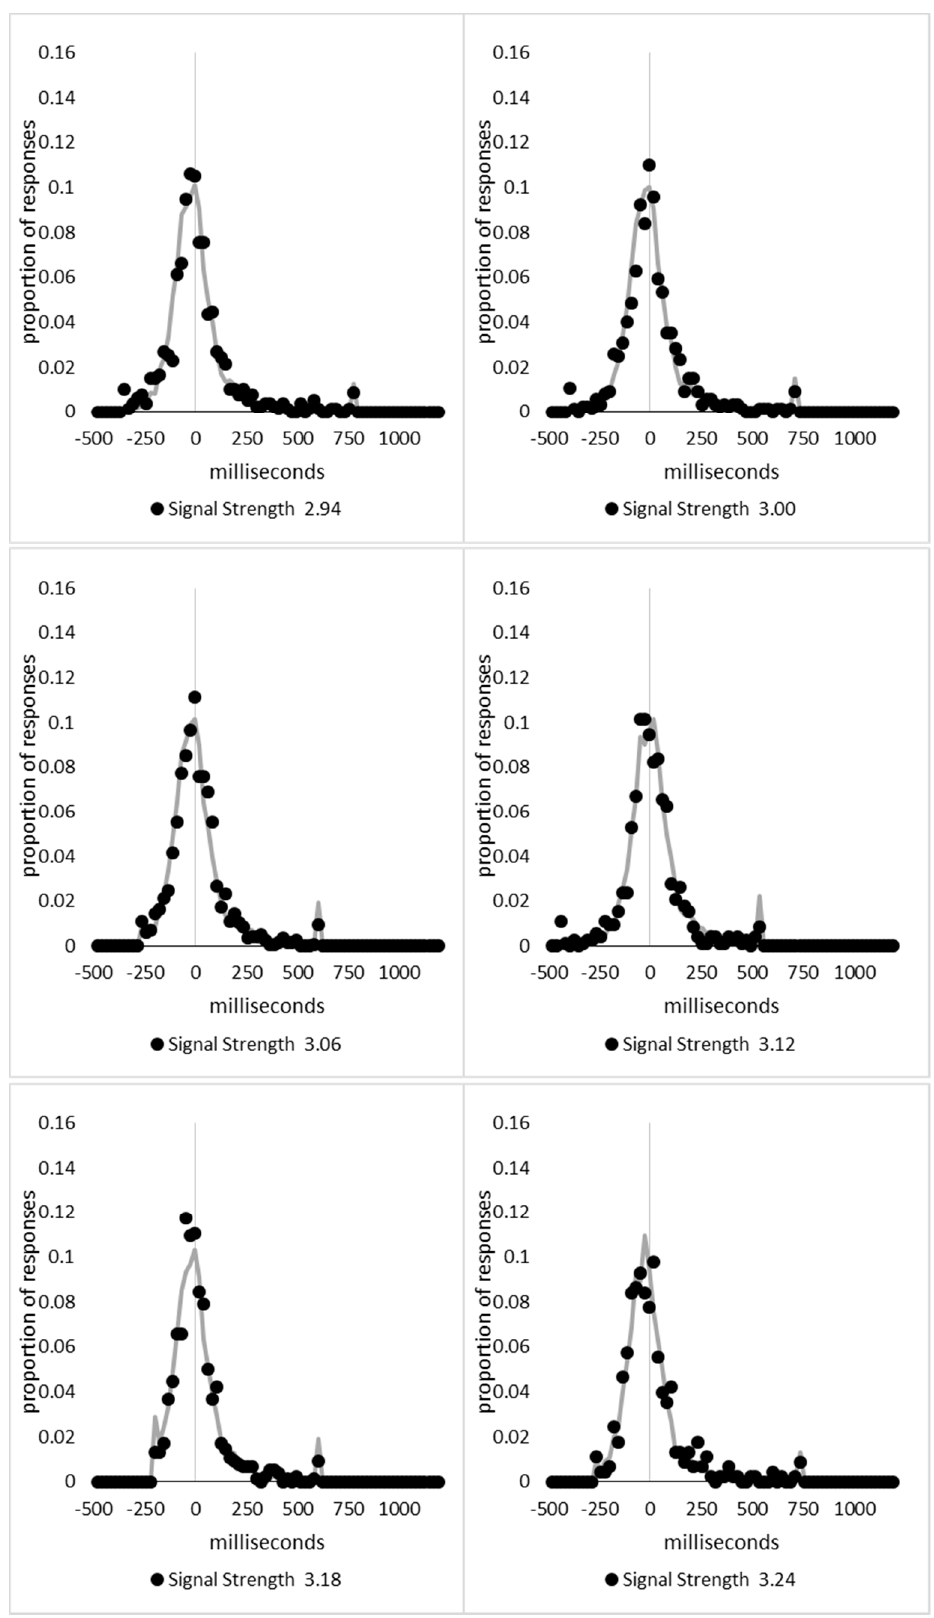
Figure A9. Density functions of the observed data (filled circles) and model (solid line) for signal strength bins 2.94 to 3.24.